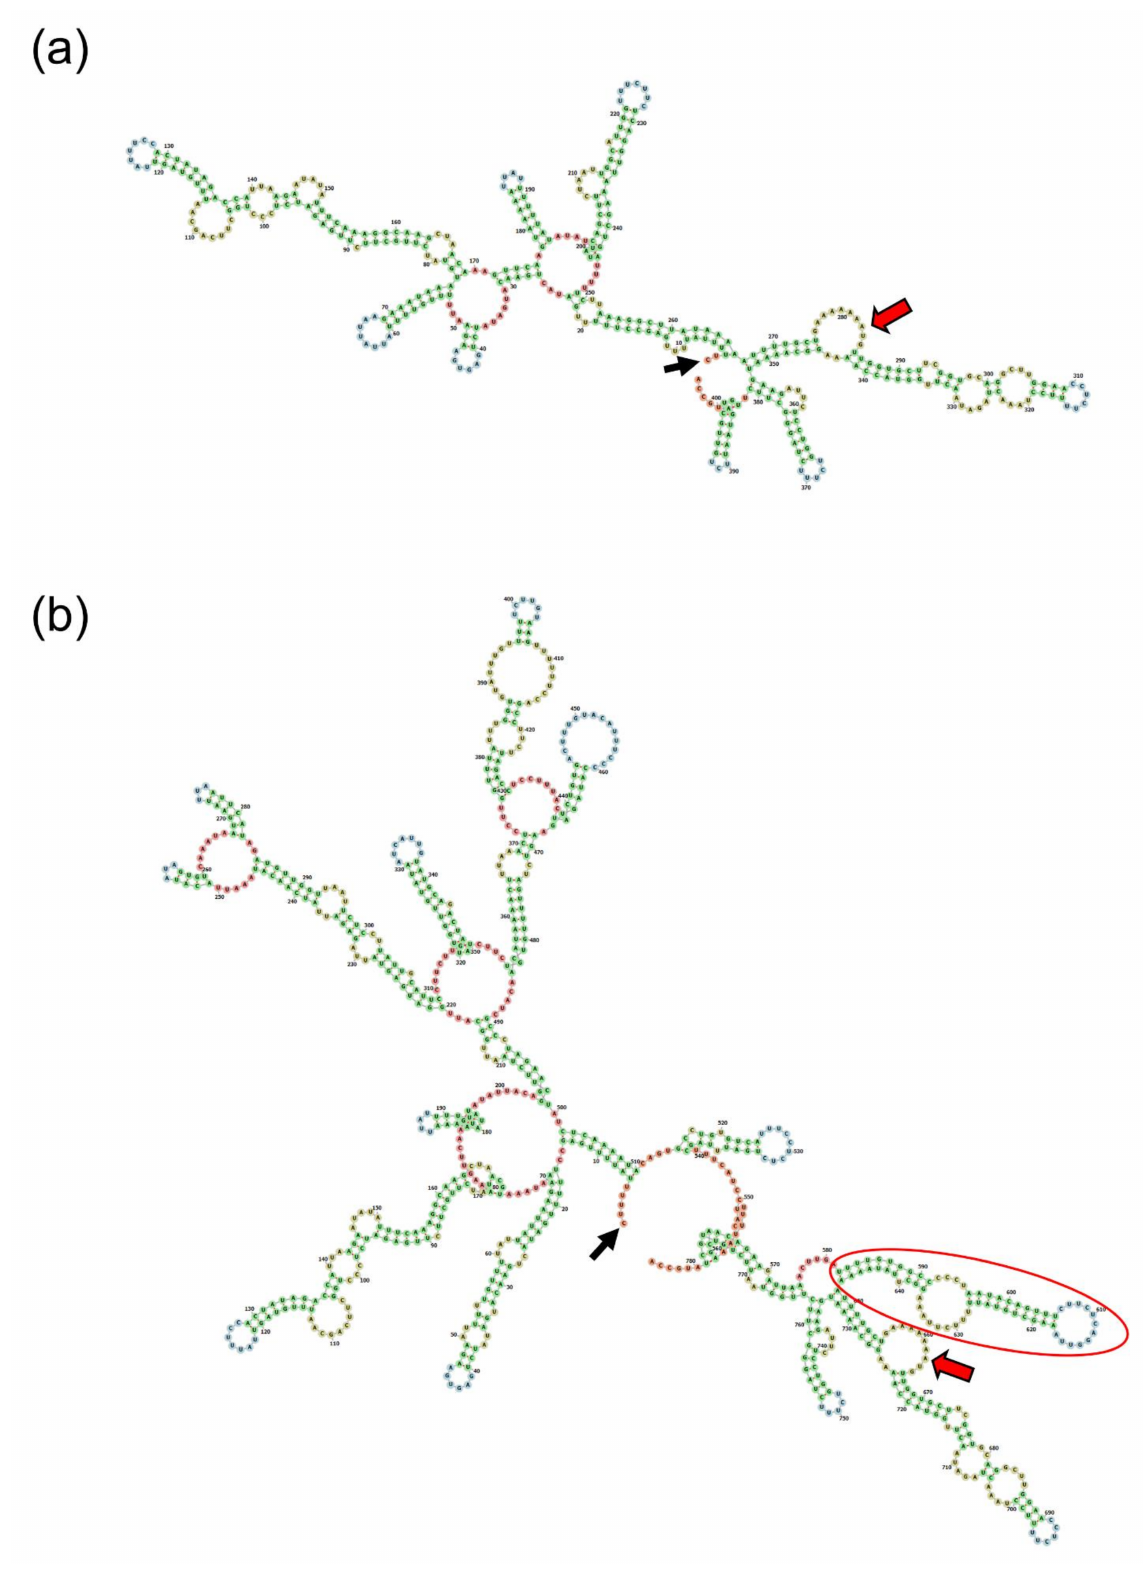
Figure 4. Predicted secondary structure of mRNA. ( a ) The wild-type mRNA structure. Left half is 5 (cid:48) UTR, and the starting nucleotide is indicated with a black arrow. Translation initiation sequence is indicated with a red arrow. ( b ) The mutant mRNA structure. Long complex structures can be seen in the 5 (cid:48) UTR, and a hairpin (red circle) is located right before the translation initiation